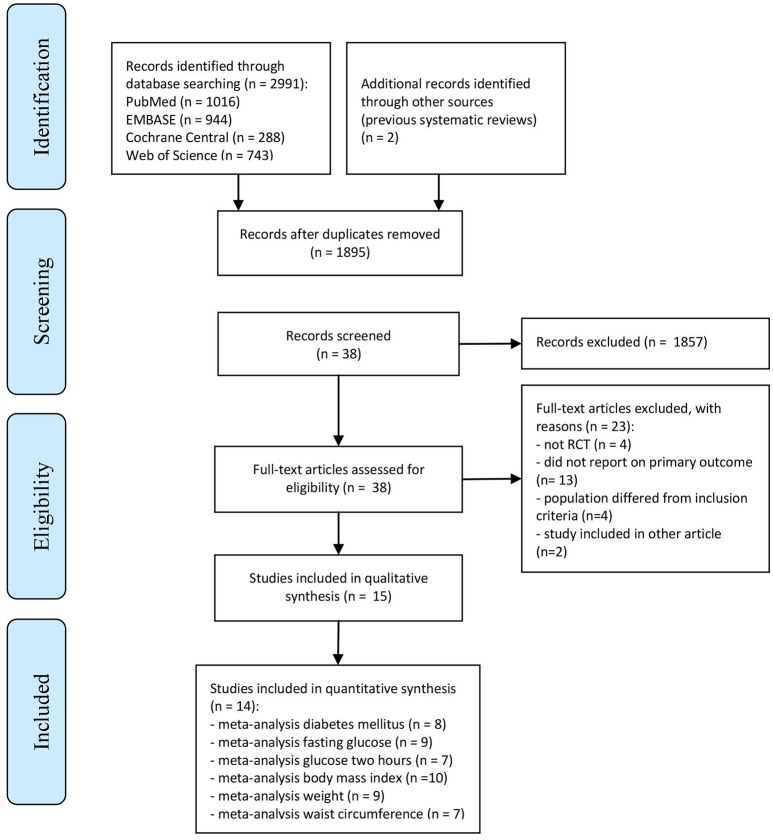
Flow chart summarizing the process for the identification of the eligible studies.